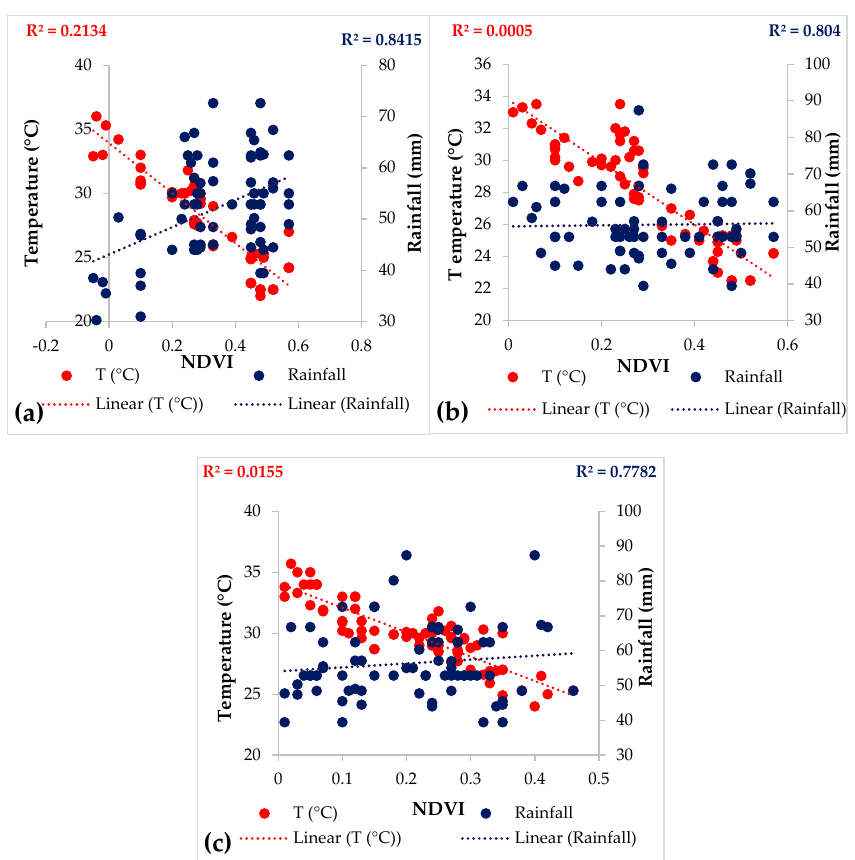
Figure 8. Relationship of temperature, rainfall and NDVI of the Sahiwal District, ( a ) 1981, ( b ) 2001, and ( c ) 2021.